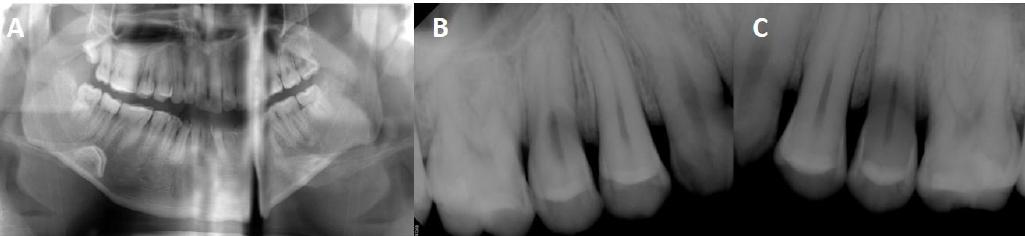
Figure 2. Pretreatment radiographs. ( A ), Panoramic radiograph. ( B ), Periapical radiograph of the maxillary right second premolar. ( C ), Periapical radiograph of the maxillary left second premolar. Severe dental caries with an extensive radiolucent area were observed in the root of the maxillary right and left second premolars.